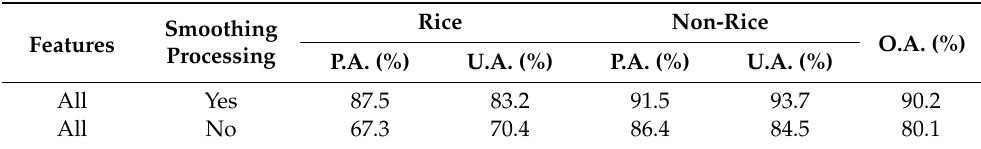
Table 5. Detection accuracy of the combined features with and without smoothing processing for VH polarization with ascending orbit mode.